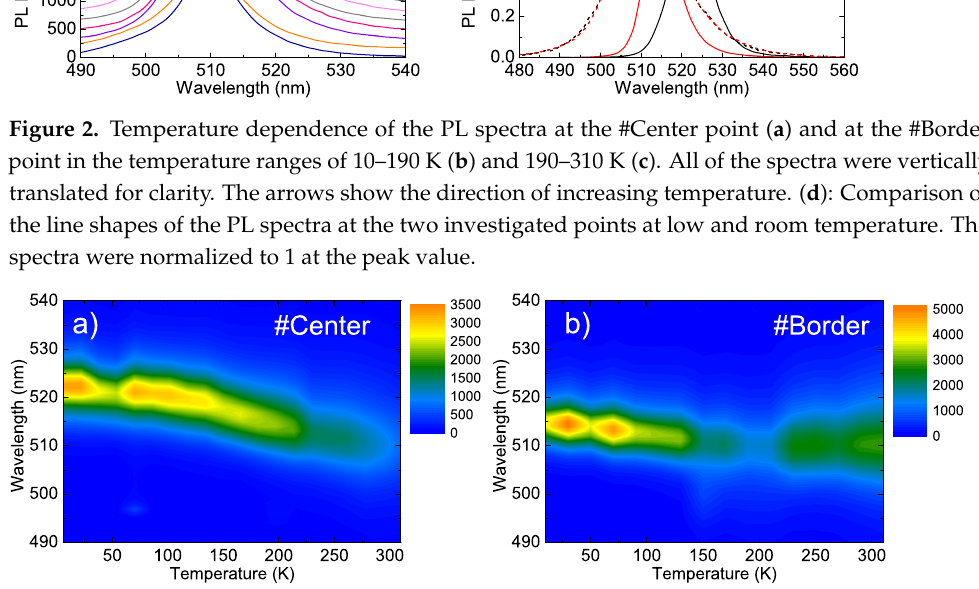
Figure 3. Two-dimensional map showing the temperature dependence of the PL at the #Center point ( a ) and #Border point ( b